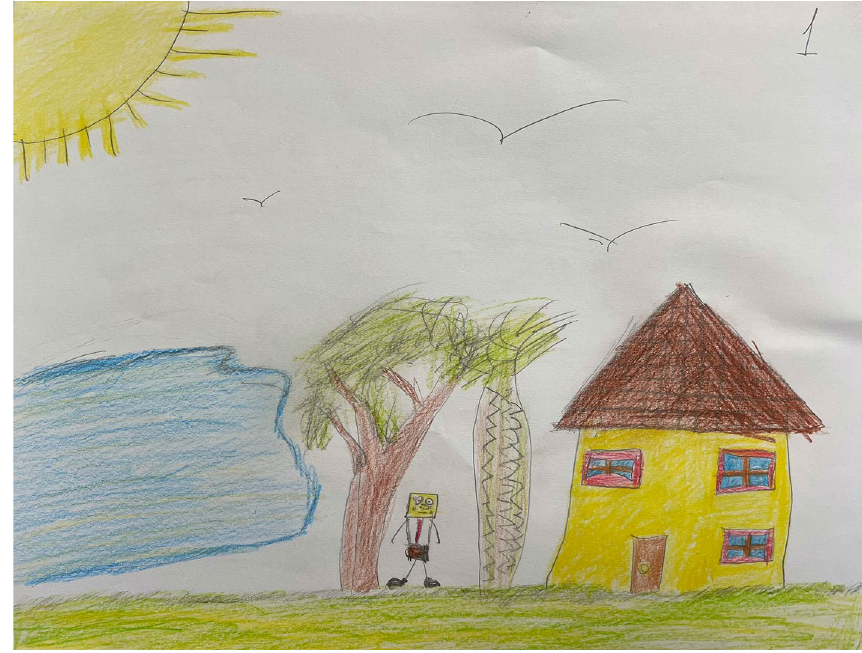
Table 3 Frequency of each identified concept during participant observations of each stage/grade